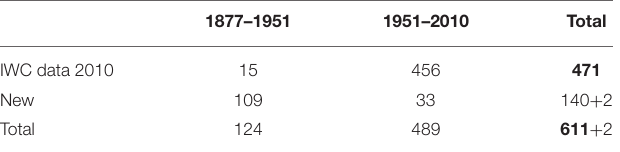
TABLE 2 | Summary of the number of unique worldwide vessel strike reports ( + denotes extra reports where the witness identifies collision as “possible whale,” bold entries correspond the numbers used in the approximate comparison between Australia and world